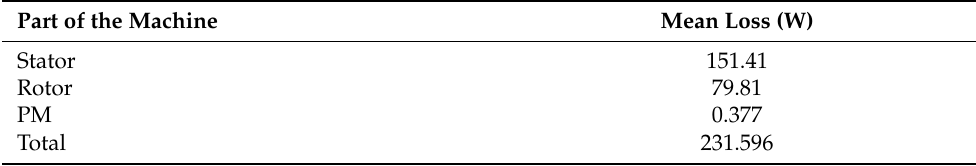
Table 4. Summarized losses calculation results (through FEA) of